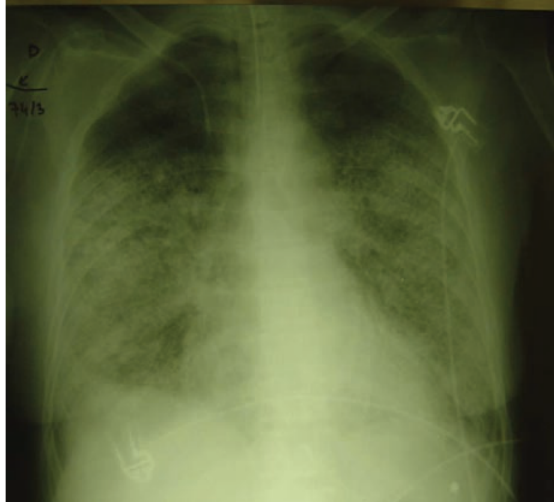
Figure 1. Admission chest